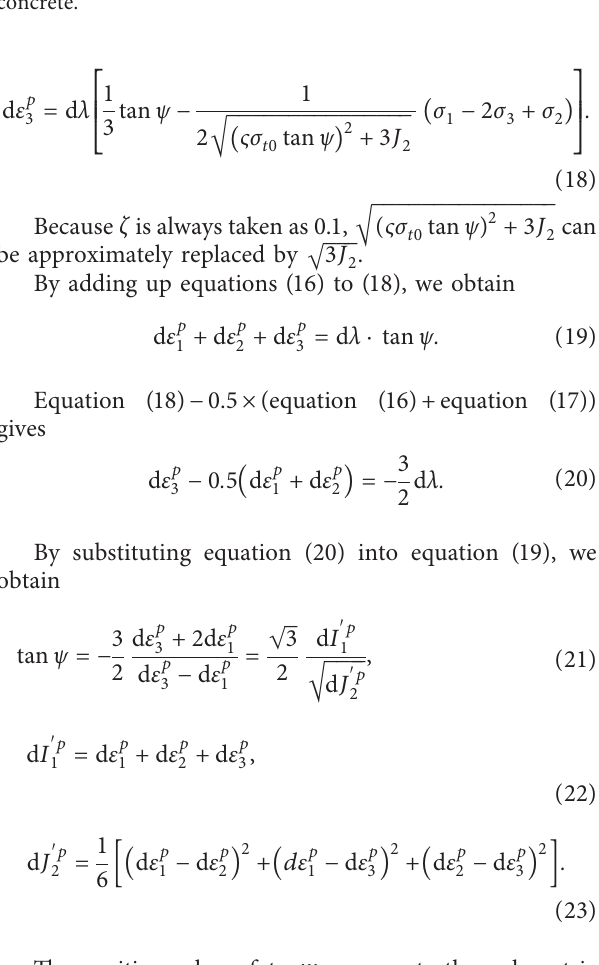
Figure 3: Calibration for the yield criterion of uniform confined